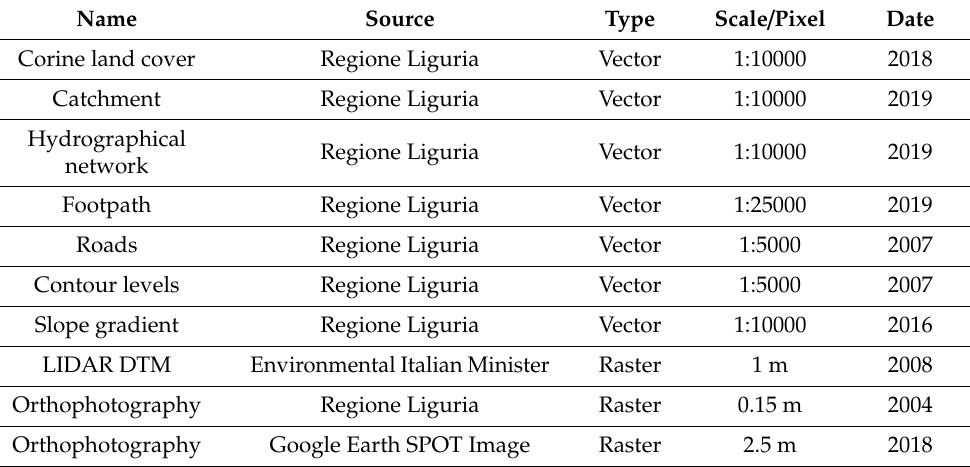
Table 3. Vector and raster data